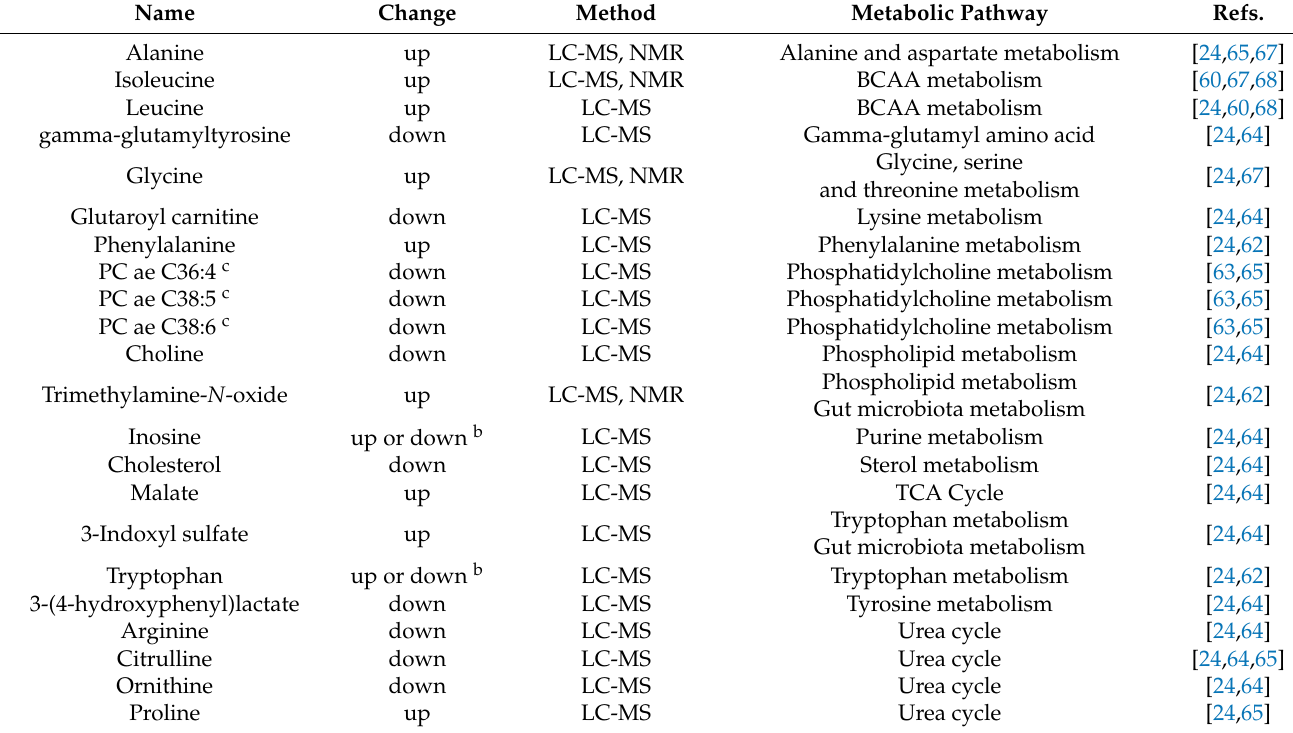
Table 2. Summary of plasma metabolite changes following metformin treatment in T2DM patients ( p ≤ 0.05) a